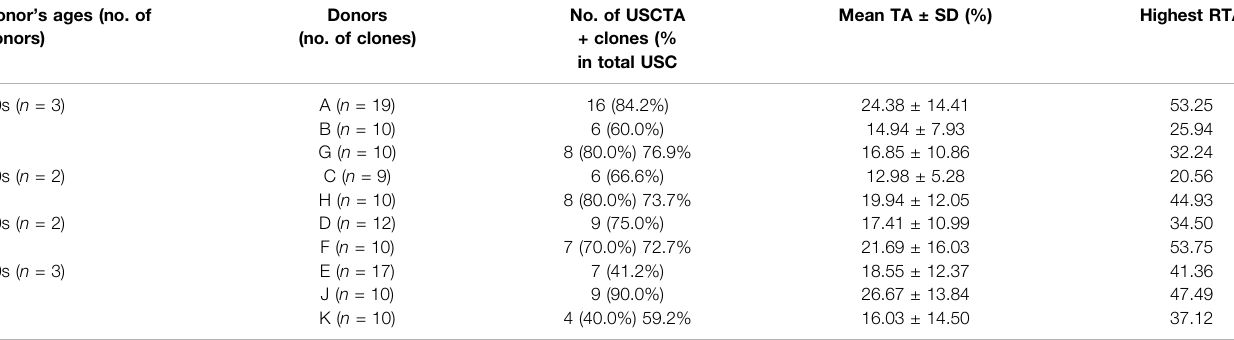
TABLE 1 | The rate, mean, and highest telomerase activity of the isolated USCs TA+ clones for individual donors (p2) in the four different age groups. Donor ’ s ages (no. of donors)